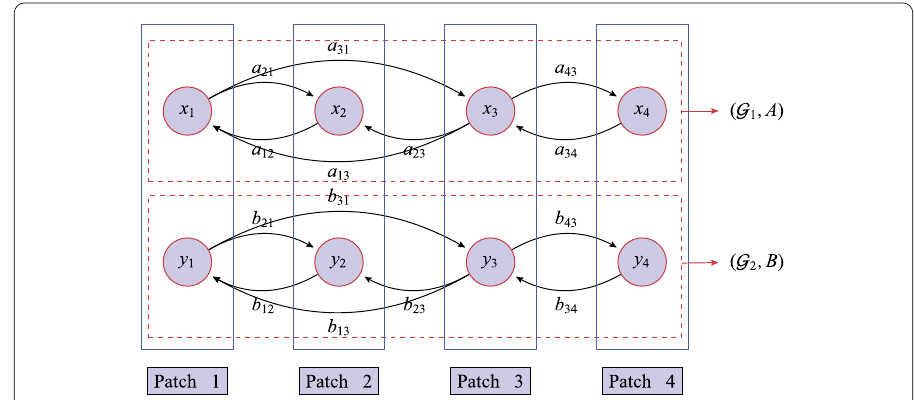
Figure 1 A structure for system (3) on four patches with two weighted digraphs: digraph ( G , ˜ A ) represents the dispersal of prey and digraph ( G , ˜ B ) represents the dispersal of